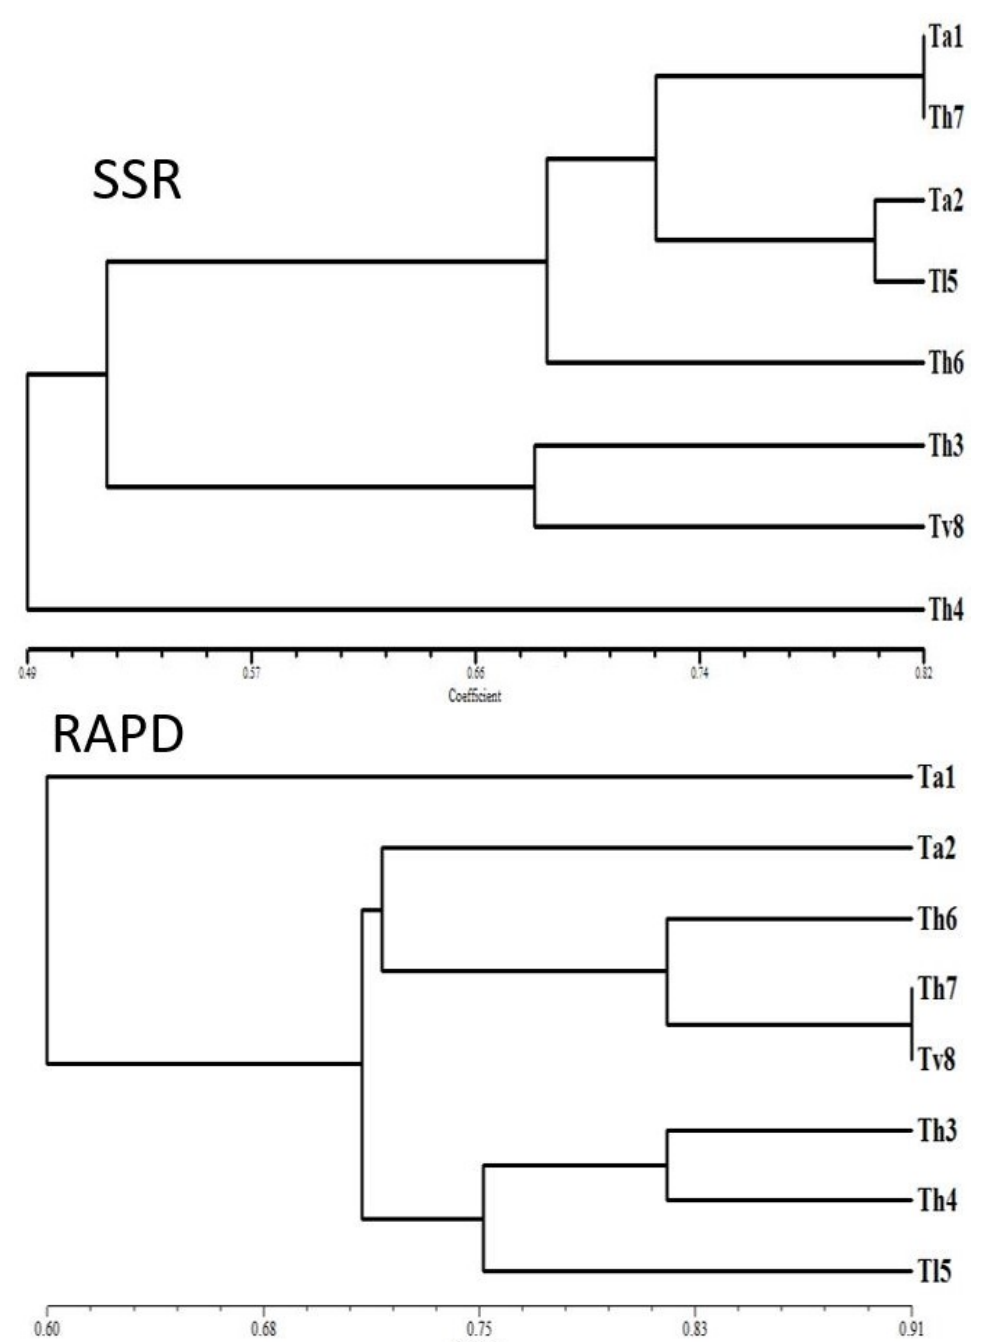
Figure 2. Dendrogram based on Jaccard’s similarity coefficients scored from RAPD and SSR data using the UPGMA algorithm representing 8 Trichoderma strains ( Ta1 , Ta2 , Th3 , Th4 , Th6 , Th7 , Tl5 and Tv8 ). Ta1 = Trichoderma asperlum ; Ta2 = Trichoderma asperlum ; Th3 = Trichoderma harzianum ; Th4 = Trichoderma harzianum ; Tl5 = Trichoderma longibrachiatum ; Th6 = Trichoderma harzianum ; Th7 = Trichoderma harzianum ; Tv8 = Trichoderma viride